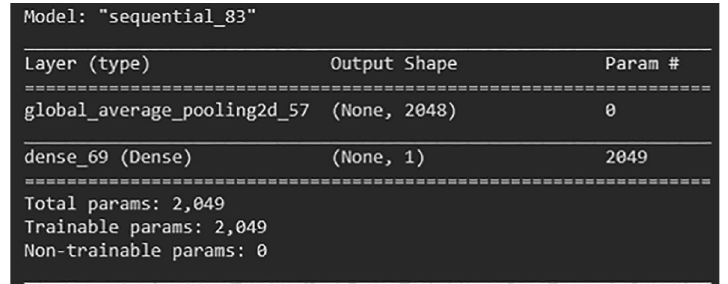
Figure 8. Architecture of the newly defined classifier.